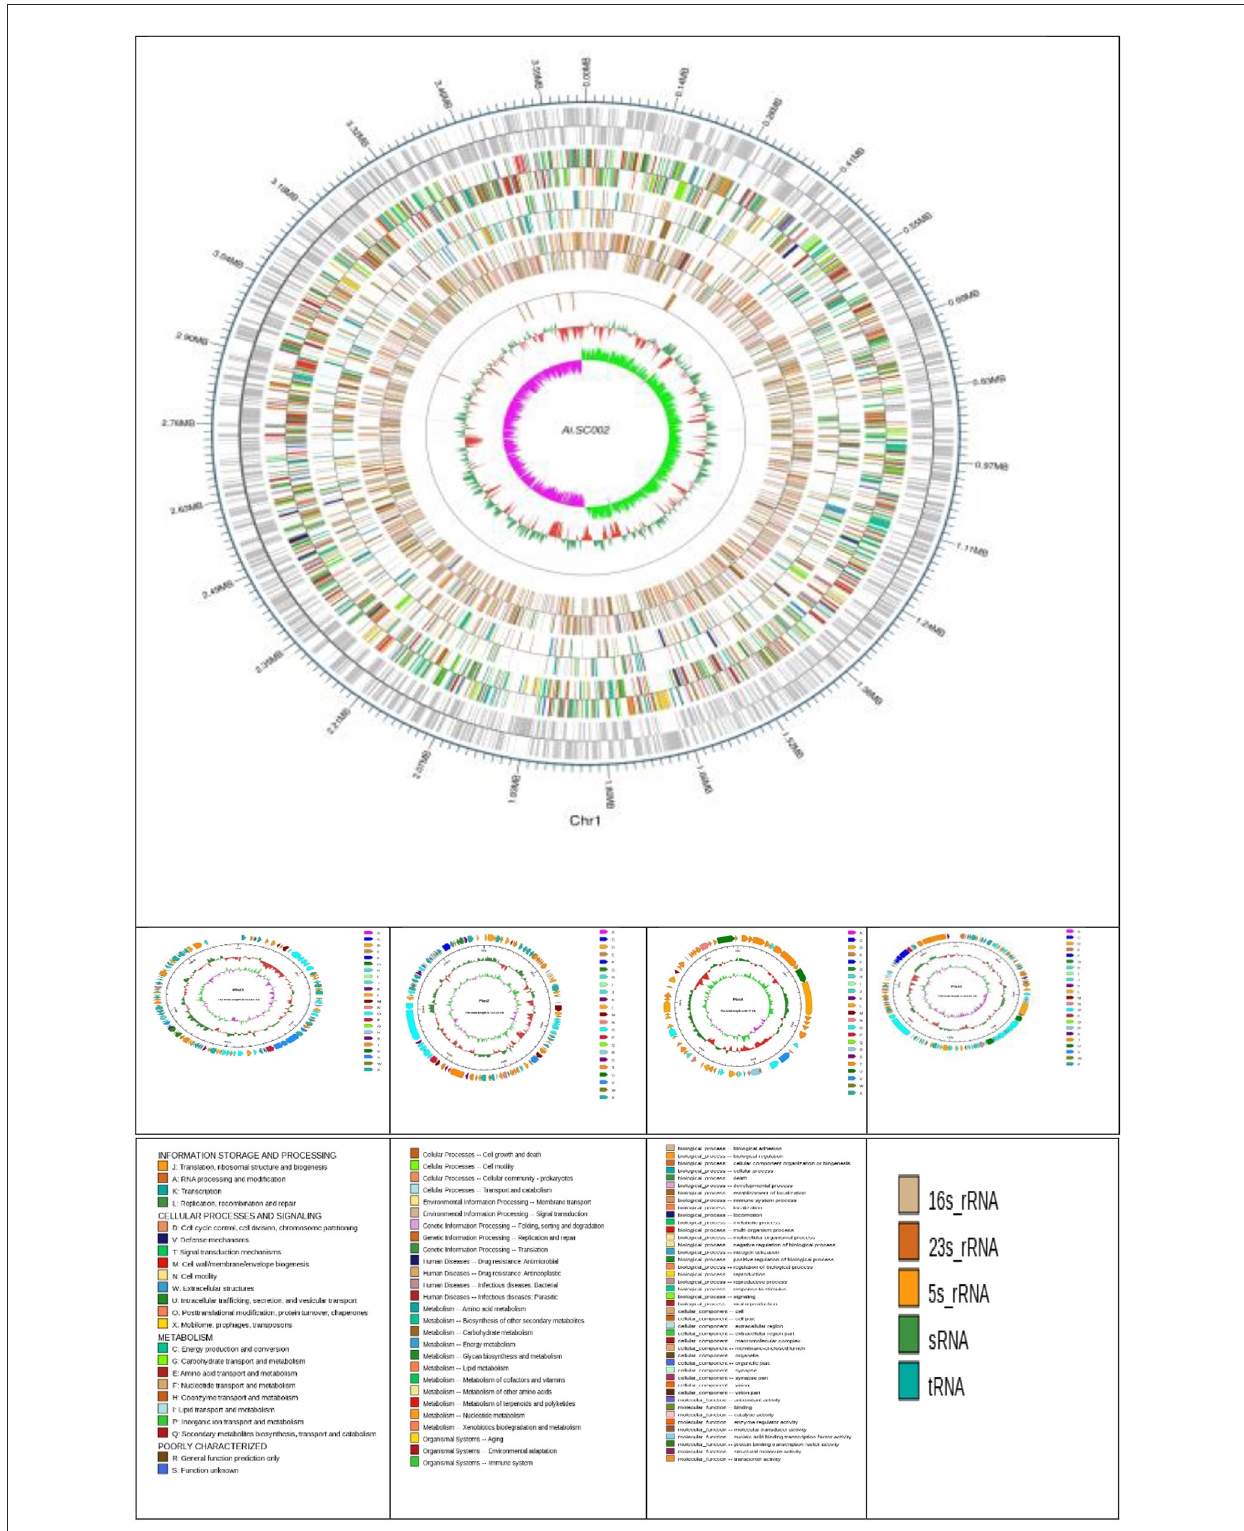
FIGURE1 Atlas of the chromosome and four plasmids of Edwardsiella tarda SC002. From the outside to the center: genome sequence coordinates, genes encoded on forward and reverse strands, followed by COG annotation, KEGG annotation, GO annotation, ncRNA, GC content, and GC skew (G–C/G + C) GC/G +